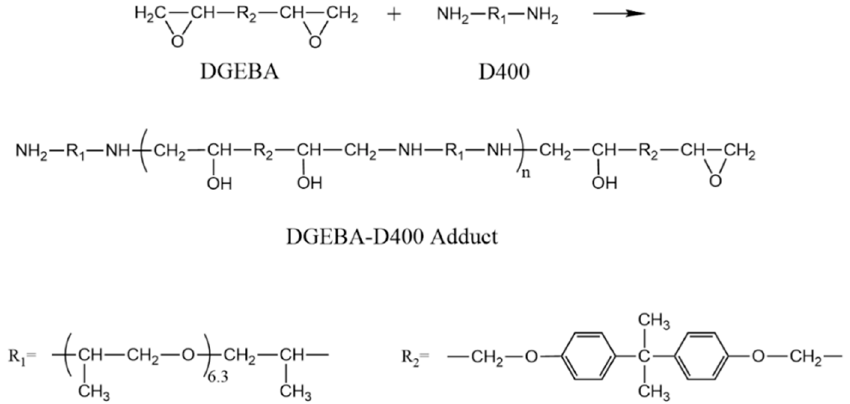
Figure 1. Synthesis of DGEBA-D400 adduct by nucleophilic addition reaction between DGEBA and D400.